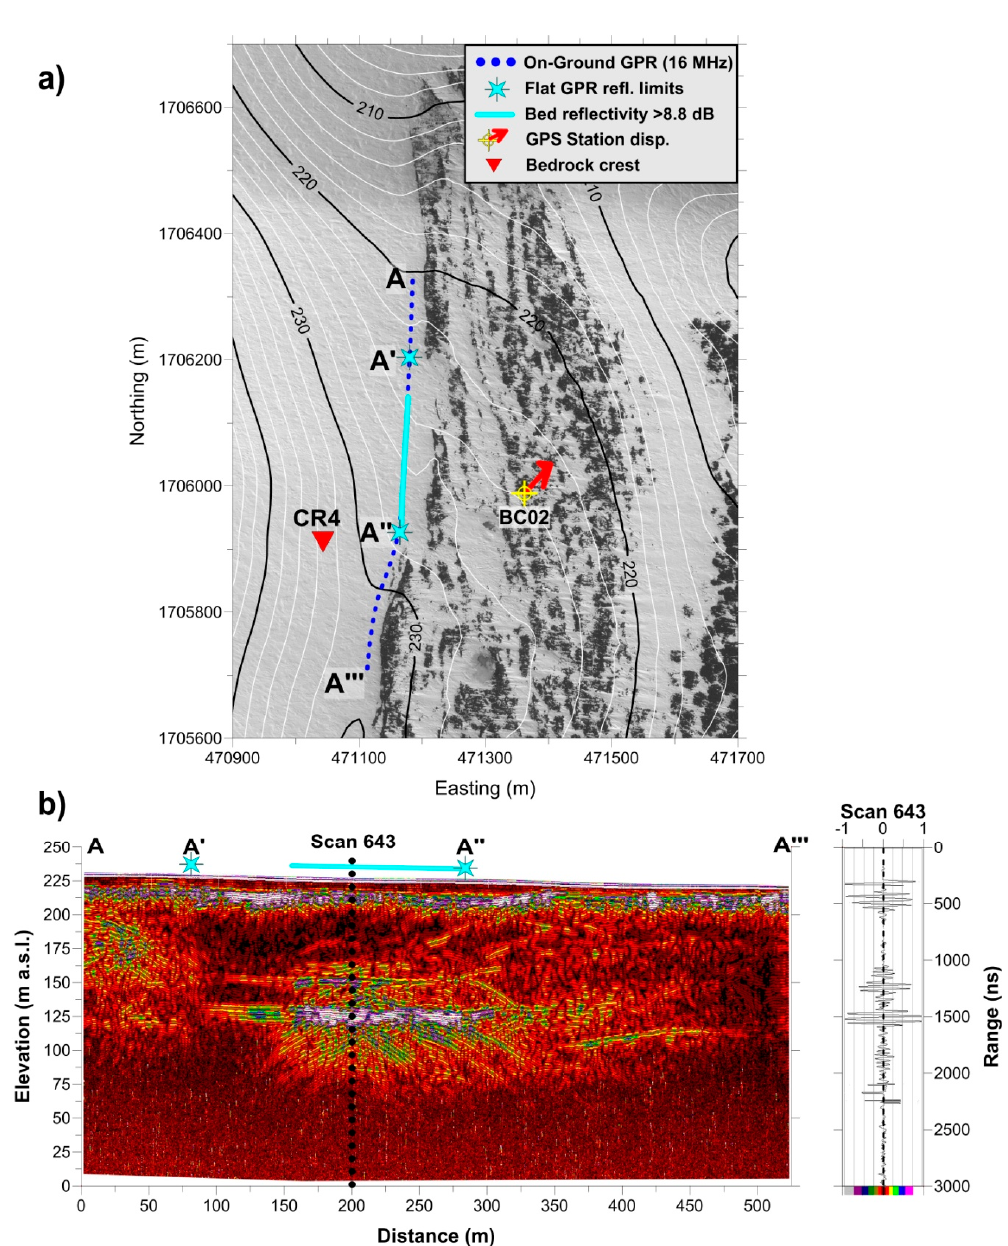
Figure 11. “Mirror” reflection recorded along the GPR profile (16 MHz) carried out at moraine limit. Map positioning ( a ) and corresponding radargram ( b ).